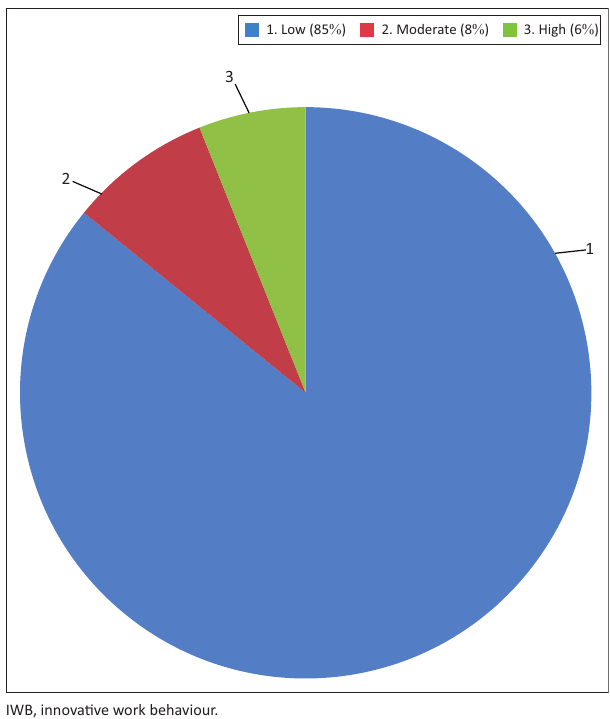
FIGURE 2: Practical significance of the regression coefficients between all subscales of the human resource practice scale and innovation across